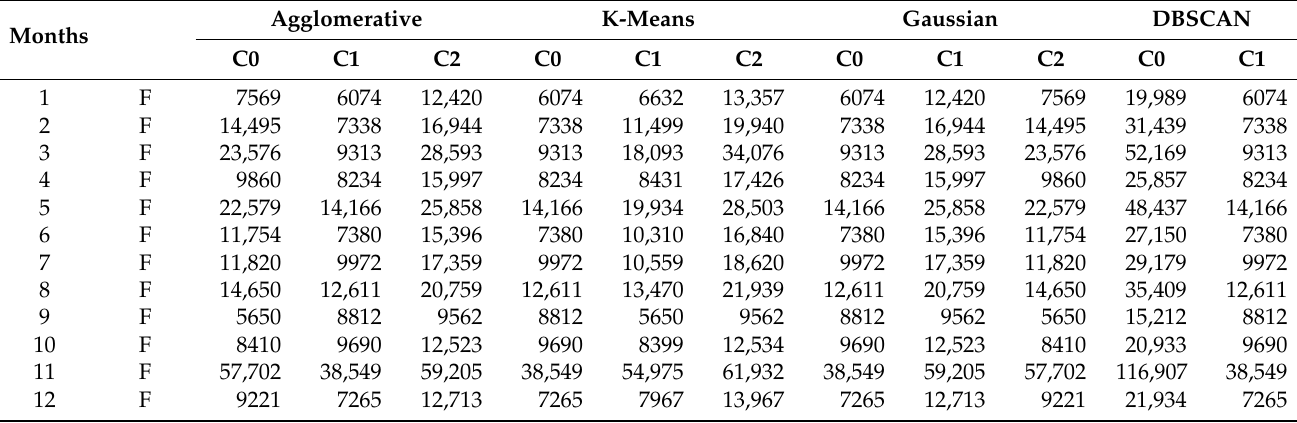
Table 10. Month-wise frequency value for different algorithm’s clusters.